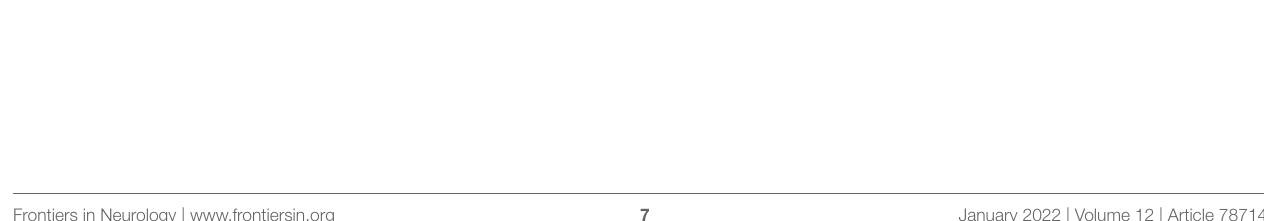
Frontiers in Neurology |